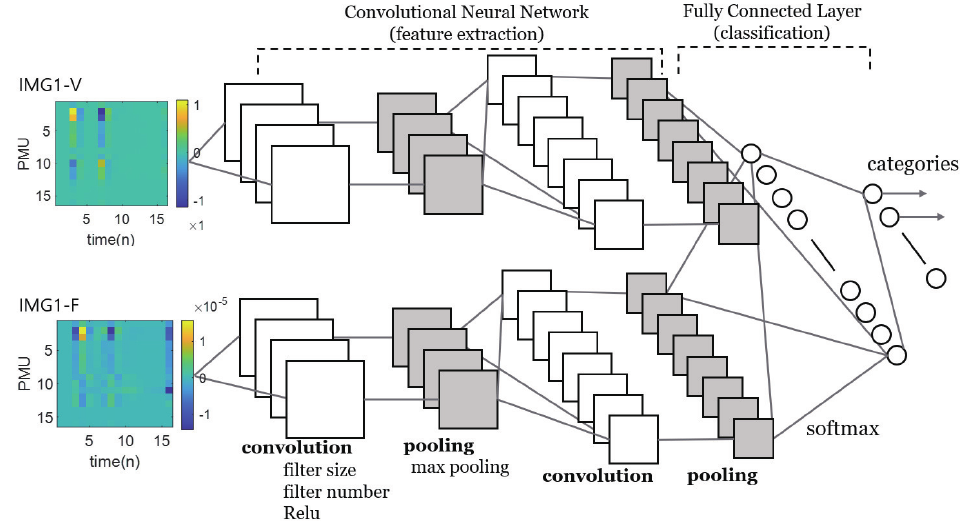
Figure 4. Multi-channels CNN structure to use the IMG1 voltage and frequency image features (C1